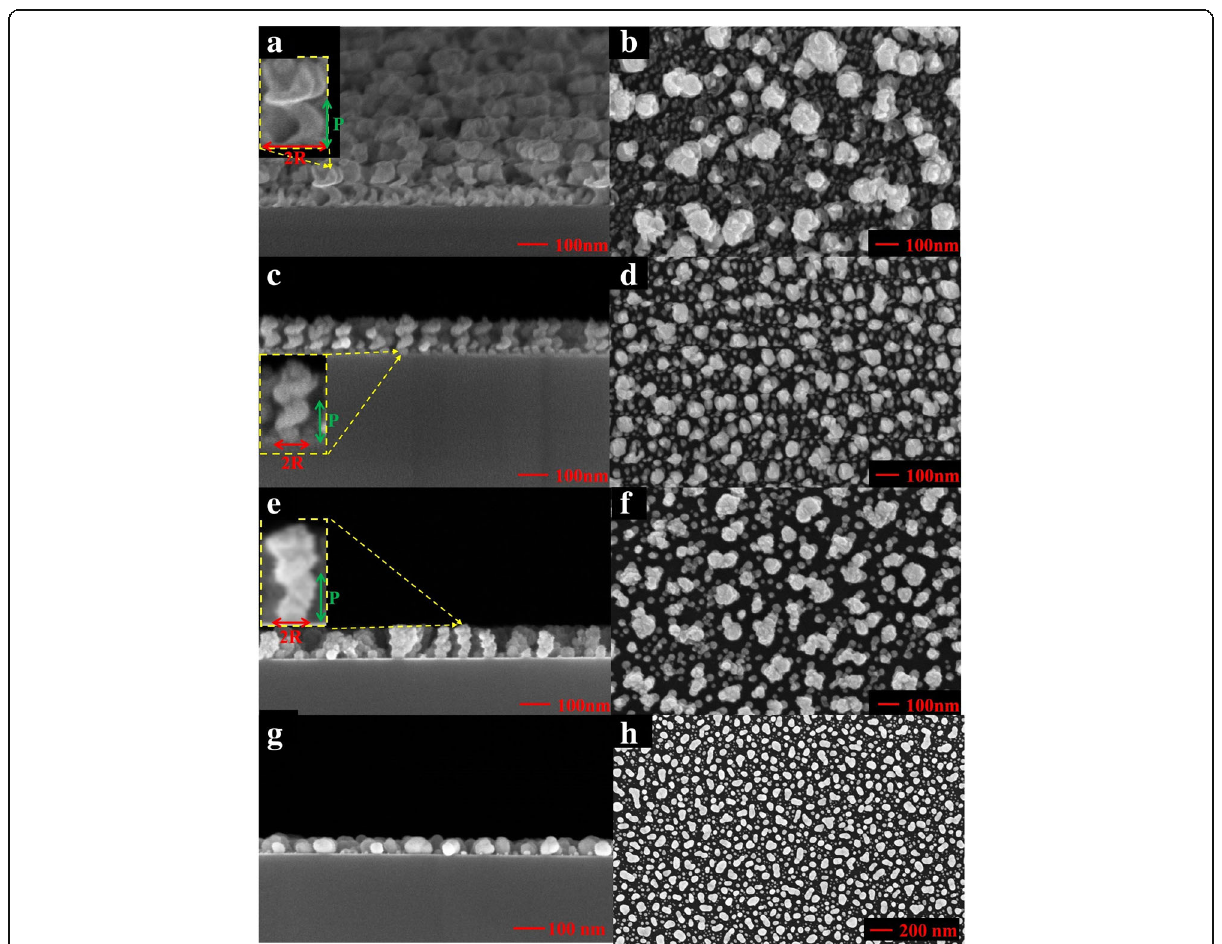
Fig. 2 Top-view and cross-section SEM images of 2-turn Au nanohelices deposited at 0.088 rpm ( a , b ), 0.117 rpm ( c , d ) and 0.160 rpm ( e , f ). Nanohelices grown on a smooth surface are shown in g and h